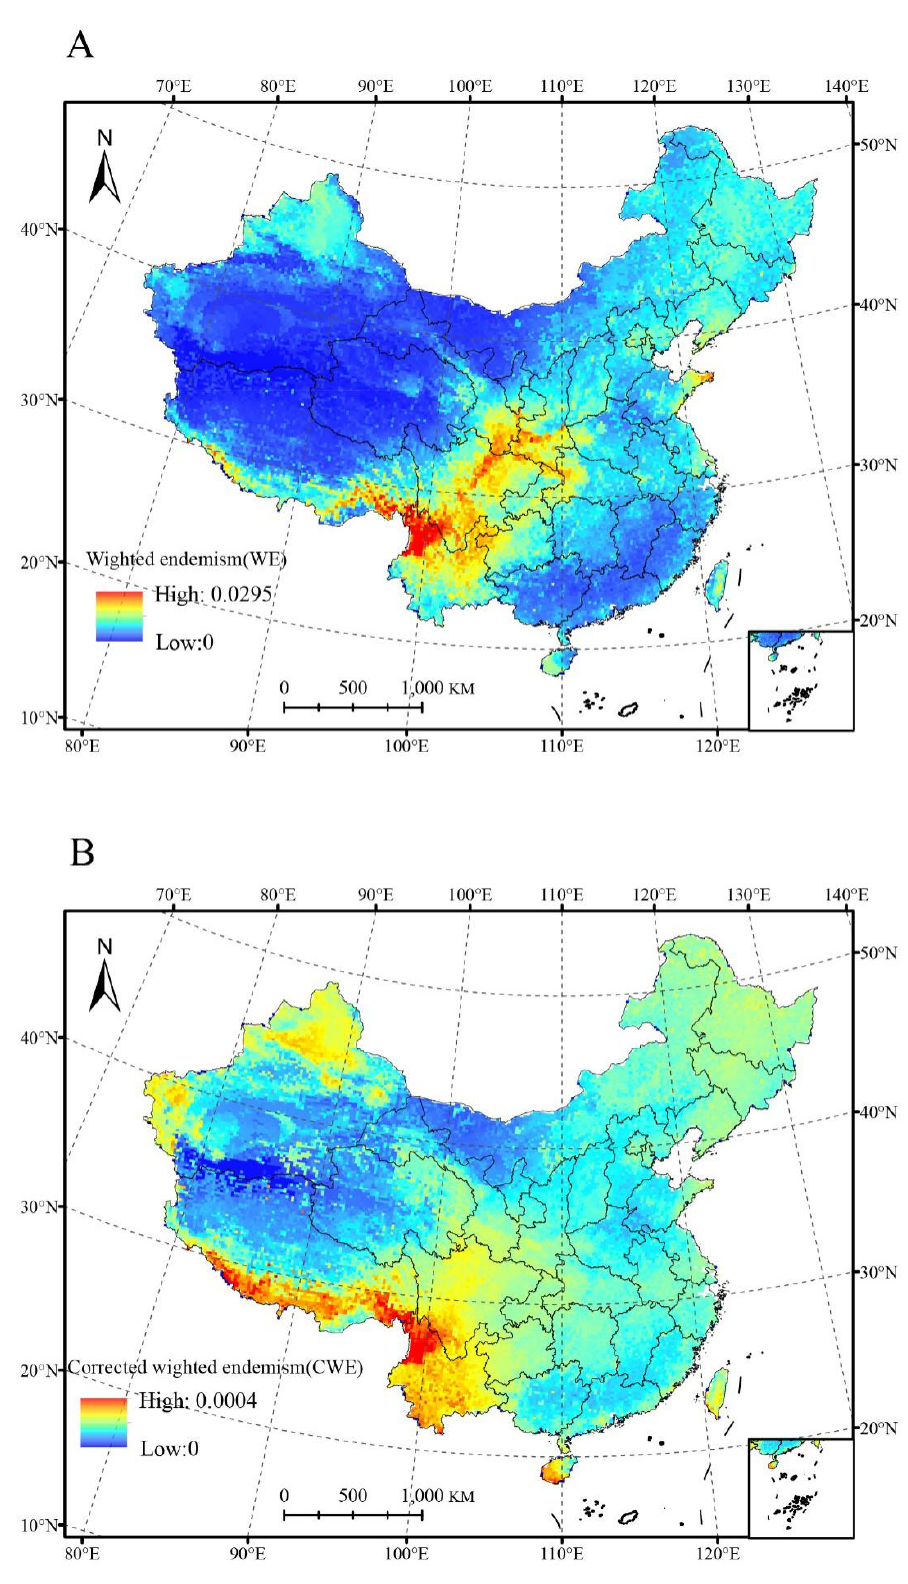
Figure 5. Patterns of weighted endemism ( A ) and corrected-weighted endemism ( B ) for Salicaceae plants in China (Albers projection). The map was plotted using ArcGIS v10.2.